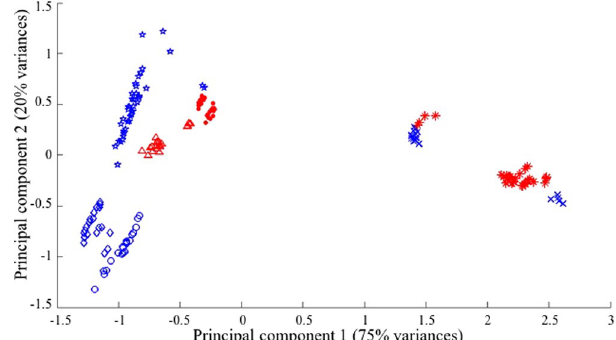
Figure 2. Score plots of principal component analysis of FT-IR original spectra. Each symbol represents one type of the sample: star, beef meat; diamond, beef honey comb tripe; cross-mark, beef liver; circle, beef omasum; triangular, pork heart; dot, pork kidney; and asteroid, pork liver. Symbols with blue colors represent tissue samples from beef, while red color symbols are samples from pork